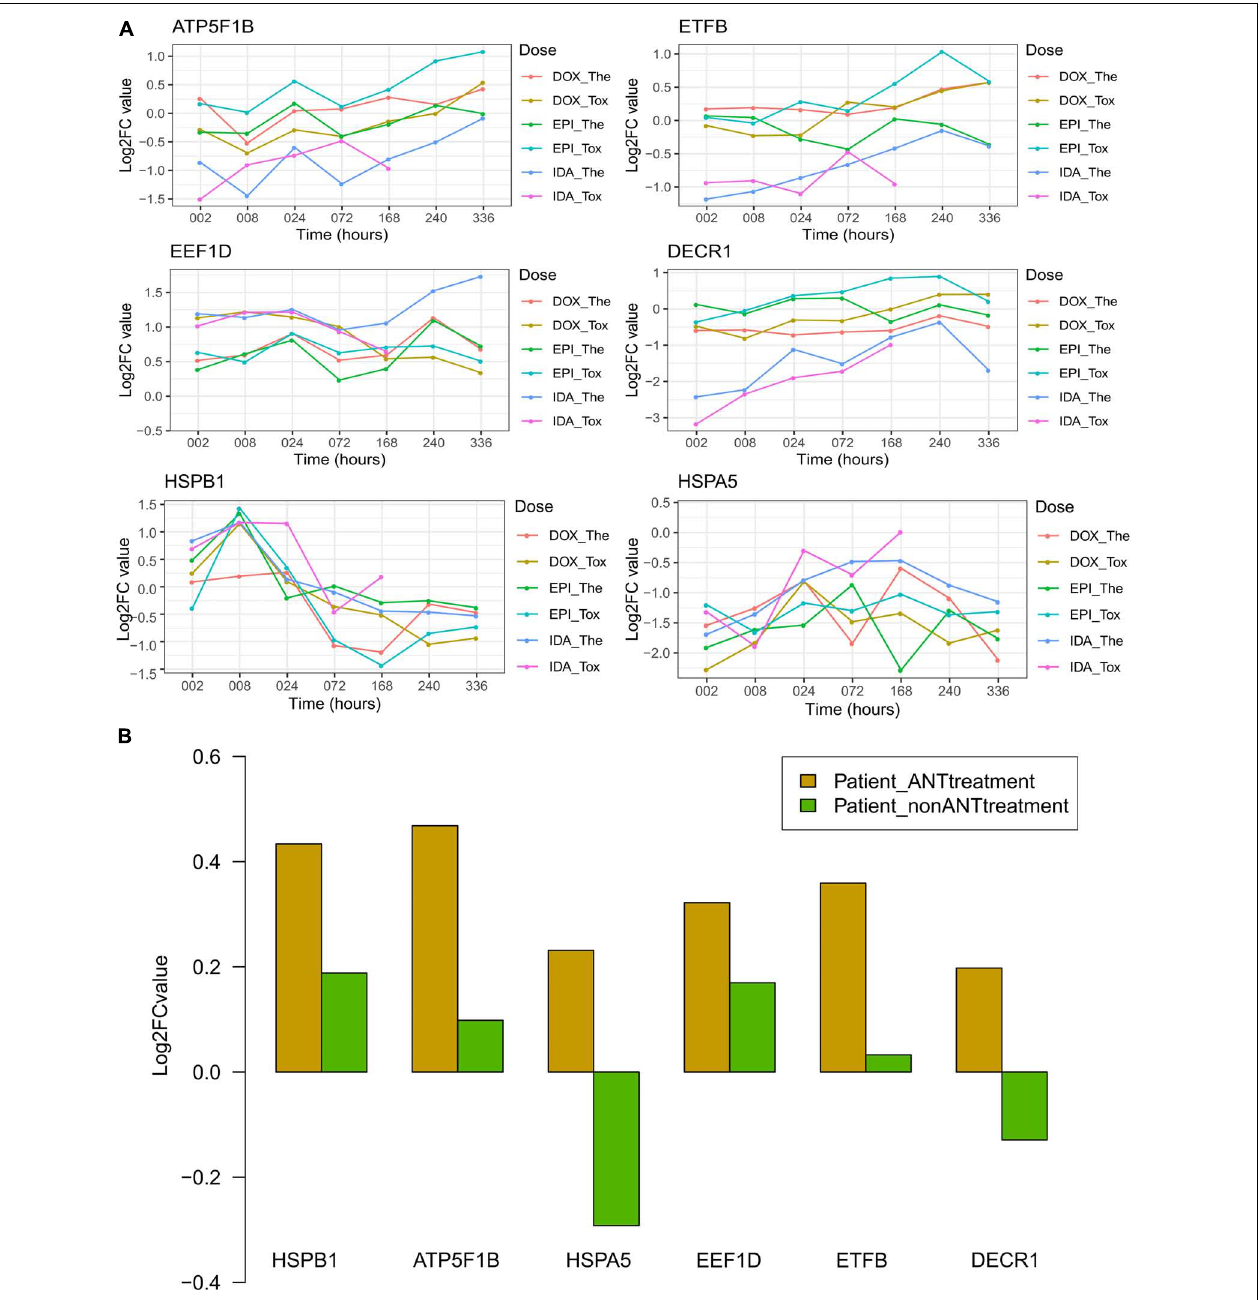
FIGURE 6 | The log2FC expression of selected proteins in the in vitro and human biopsies datasets. Protein names and its UniPort IDs: ATP5F1B (P06576), EEF1D (P29692), ETFB (P38117), DECR1 (Q16698), HSPA5 (P11021), and HSPB1 (P04792). (A) The log2FC value of in vitro data resulted from the comparison of protein expression levels in anthracyclines (ANTs) samples to control samples per time point. (B) The log2FC value of human biopsies data resulted from the protein expression levels in heart failure patients having cancer therapy with or without ANTs compared to the heart failure patients with no cancer (control group). Patient_ANTtreatment: heart failure patients that had cancer treatment with ANTs; Patient_nonANTtreatment: heart failure patients that had cancer treatment without ANTs.